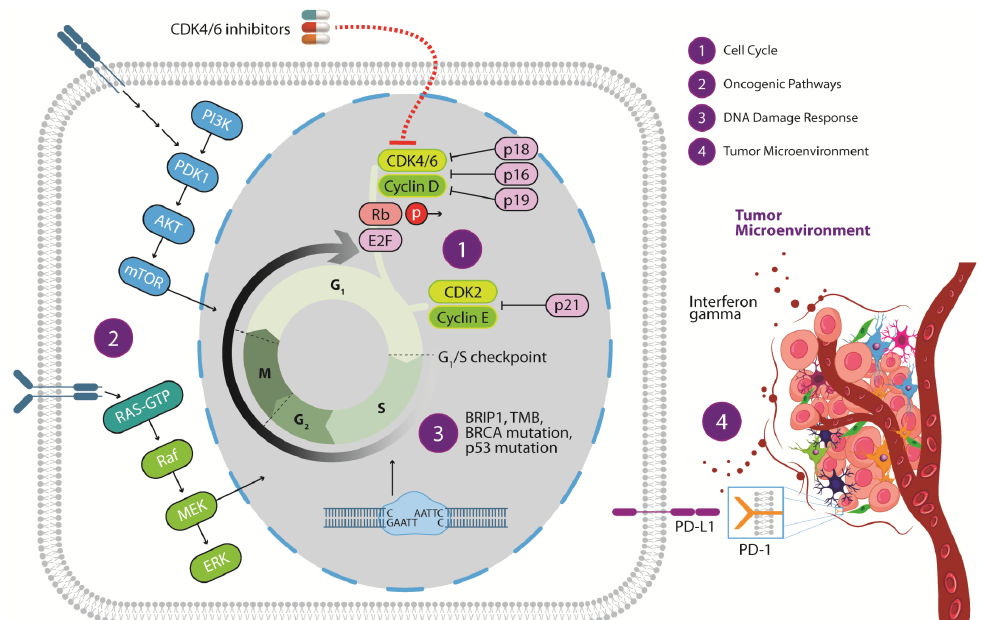
Figure 1. Mechanisms of resistance to CDK4/6 inhibitors. (1) Mechanisms related to the cell cycle; (2) oncogenic signaling pathways; (3) DNA damage response and repair deficiency; (4) mechanisms related to the microenvironment. PI3K: phosphoinositide 3-kinase; PDK1: 3-phosphoinositide- dependent protein kinase 1; AKT: protein kinase B; mTOR: mammalian target of rapamycin; RAS- GTP: RAS proto-oncogene GTPase; RAF: RAF proto-oncogene serine/threonine protein kinase; MEK: Mitogen-activated protein kinase; ERK: extracellular signal-regulated kinases; Rb: RB transcriptional corepressor; p16: cyclin-dependent kinase inhibitor 2A; p18: cyclin-dependent kinase inhibitor 2C; p19: cyclin-dependent kinase inhibitor 2; E2F: E2F transcription factor; CDK: cyclin-dependent kinase; p21: cyclin-dependent kinase inhibitor 1A; BRIP1: BRCA1 interacting helicase 1; BRCA : breast cancer gene; HRR: homologous related repair; PD-1: programmed cell death protein 1; PD-L1: programmed cell death protein 1 ligand; TMB: tumor mutational